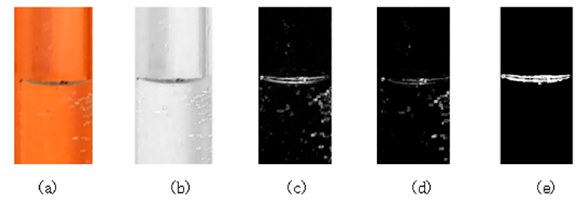
Figure 13. Recognition results for the adaptive gray method applied to the liquid tube, including ( a ) the original image, ( b ) the adaptive gray image, ( c ) edge detection results for the adaptive grayscale image, ( d ) results for the traditional grayscale image, and ( e ) the removal of smaller connected domains.